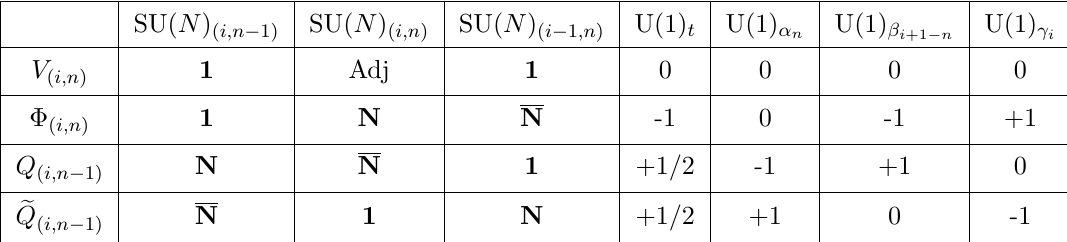
Table 2. Symmetry transformations of the fields of a Class S k